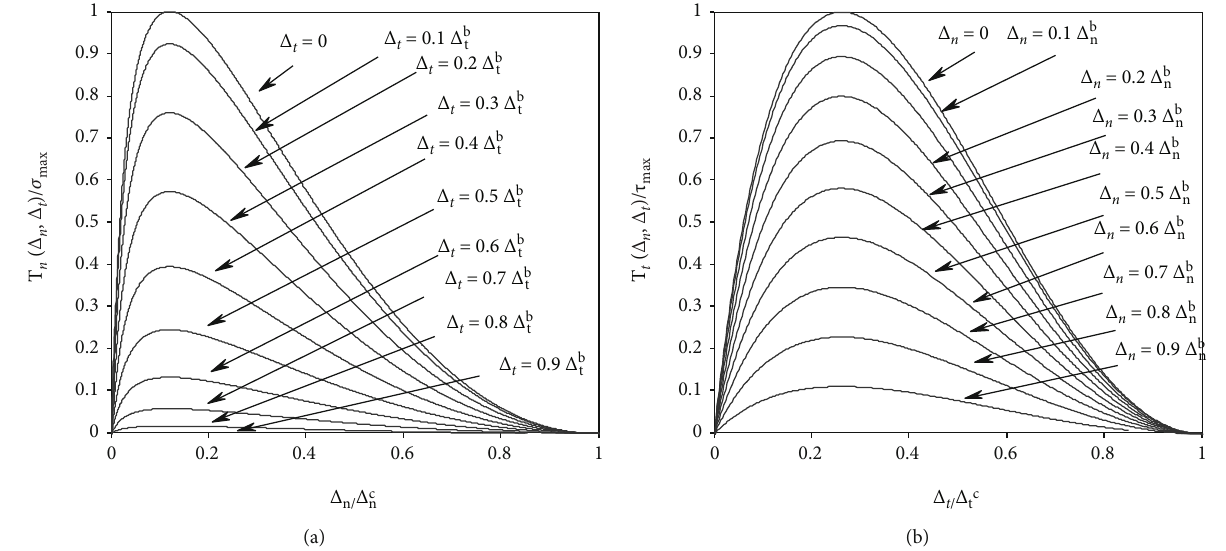
Figure 22: (a) Normal traction in PPR CZM with respect to the increase of the tangential separation; (b) tangential traction in PPR CZM with respect to the increase of the normal